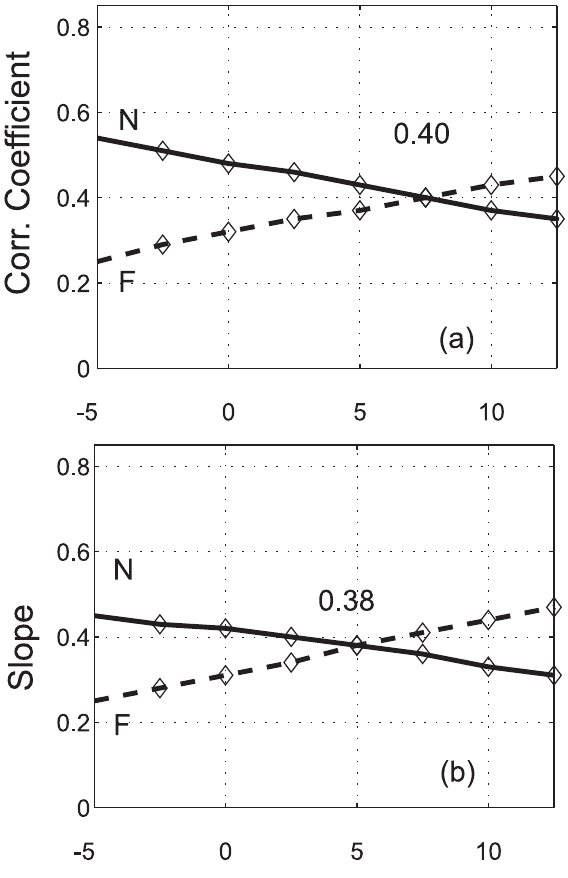
Fig. 5. The correlation coefficient and the slope of the best linear fit line to observations for various shifts in the direction of the max- imum irregularity velocity. An irregularity velocity variation with the flow angle according to Bahcivan et al. (2005) was assumed. The positive shift corresponds to the CW direction from E × B .